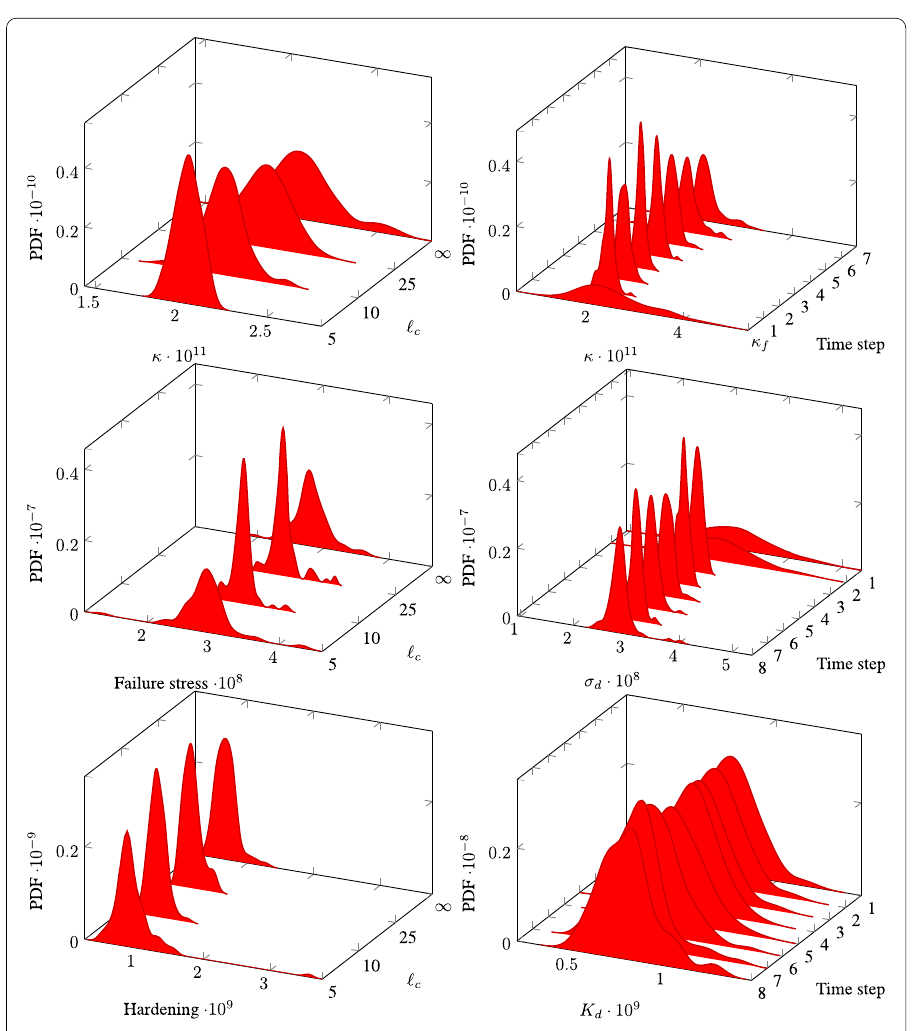
Fig. 20 The PDF of parameters κ (in Pa), Failure stress σ d (in Pa) and Hardening modulus K d (in Pa) w.r.t. the correlation length (left) (cid:23) c and time steps